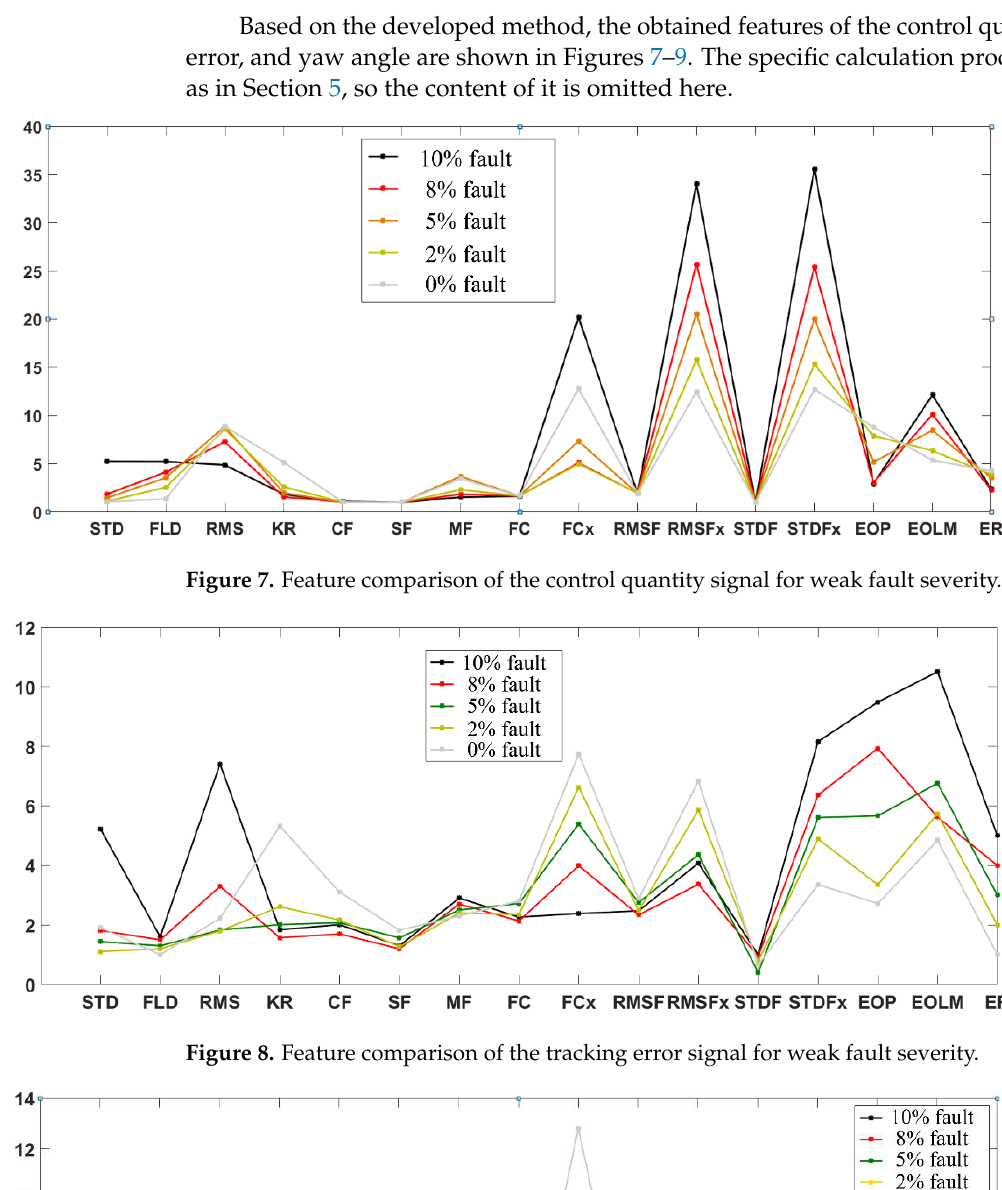
Table 7. Useful features of the control quantity. Index